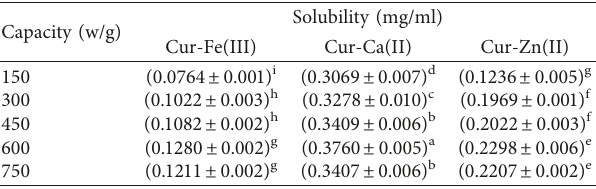
Table 3: Solubility of curcumin complexes in water solvent at different ultrasound wave capacities.